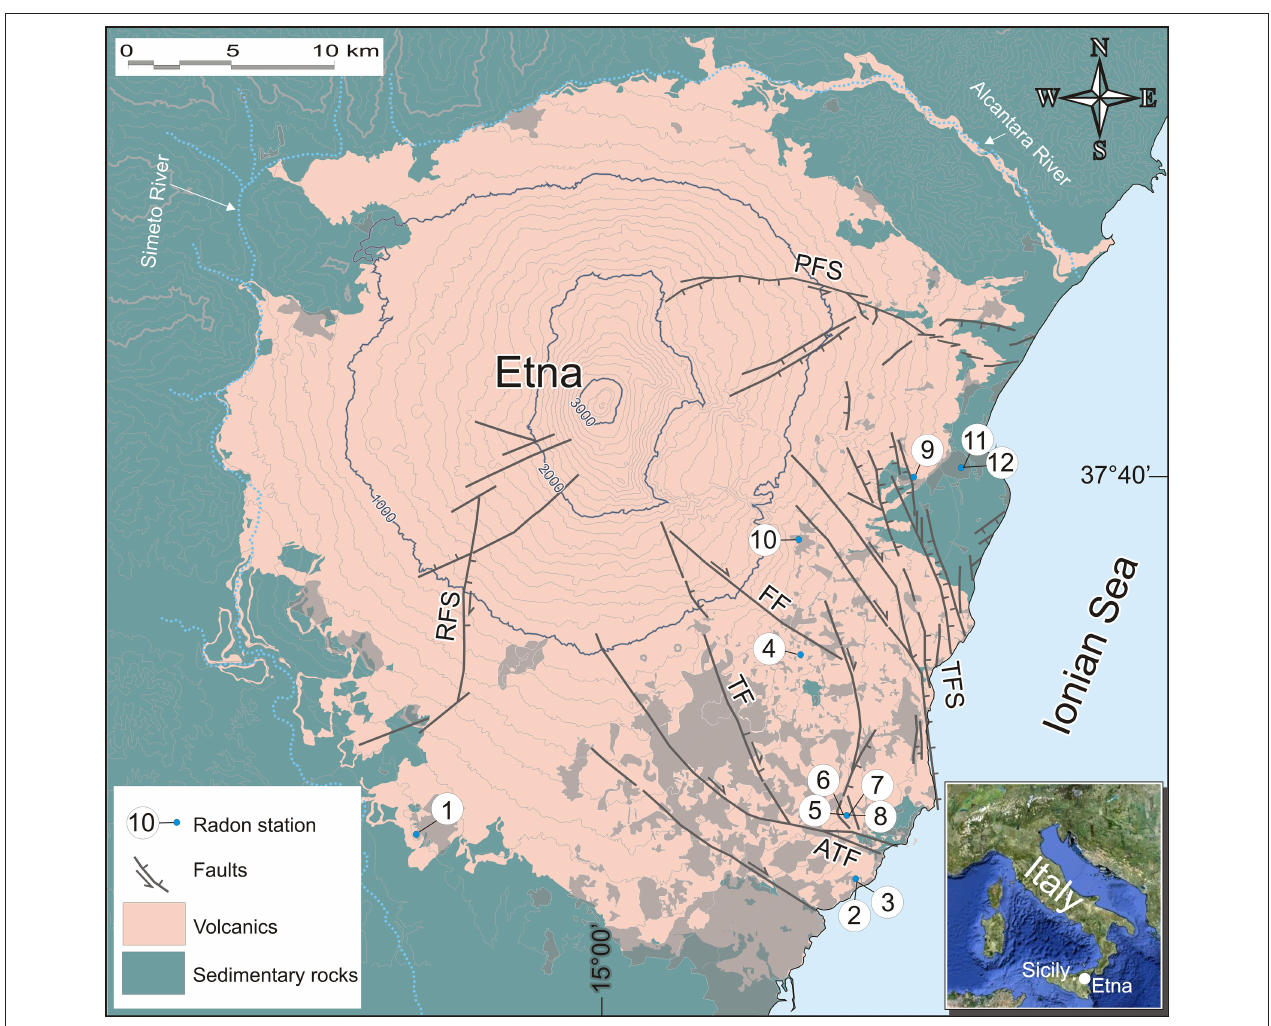
FIGURE 1 | Simplified geological map of Mount Etna showing the main faults that cross the volcano and the sites of indoor radon measurements, numbered from 1 to 12. The urbanized areas are shown in light gray. Contour lines are in meters. PFS, Pernicana fault system; RFS, Ragalna fault system; TFS, Timpe fault system; FF, Fiandaca fault; TF, Trecastagni fault; ATF, Aci Trezza